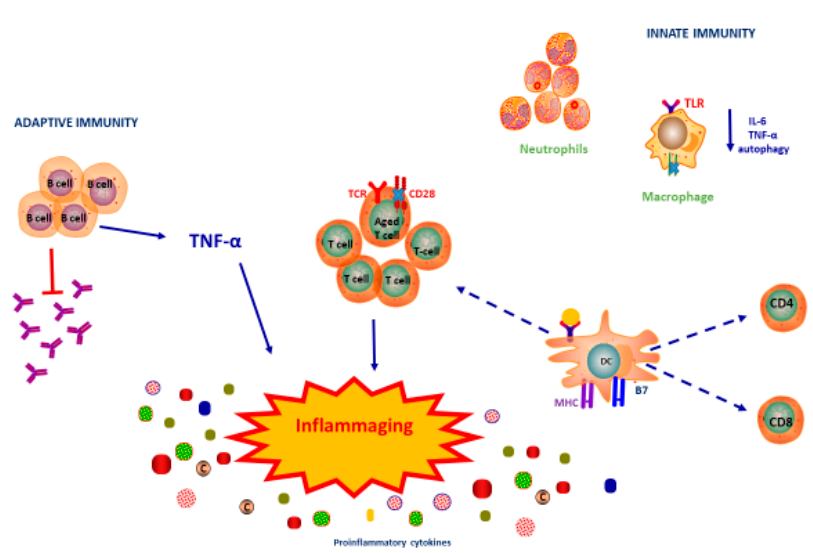
Figure 1. Immunosenescence and inflammaging. Several factors are implicated in immunosenescence. Neutrophils reduce their ability to migrate to infection sites. Macrophages show a reduction in the production capacity of cytokines. Dendritic Cells (DC) reduce their ability to present antigen and to stimulate CD4 + and CD8 + T-cell activation. B cells have an intrinsic defect in class-switch recombination and present lower production of antibodies and higher production of TNF- α that contributes to inflammaging. TNF- α inhibits the transcription of CD28. Furthermore, aged T cells show a higher secretory activity contributing to inflammaging.